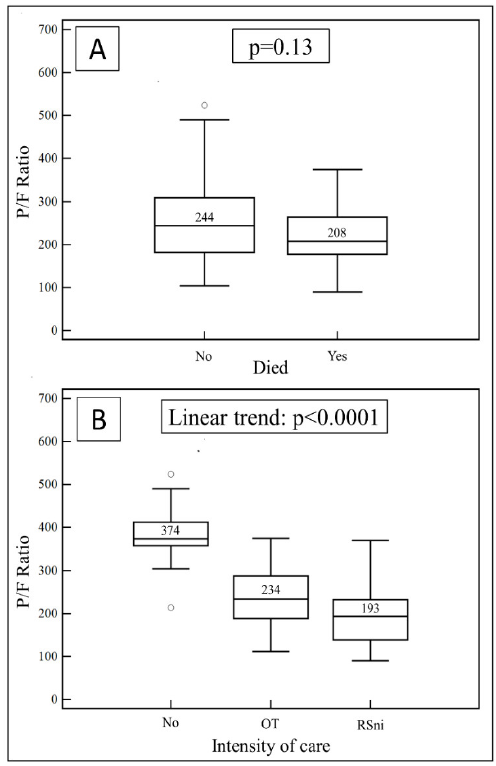
Figure 2. ( A ) PaO 2 /FiO 2 ratio values on admission in COVID-19 patients sorted on whether they died or not during hospitalization. ( B ) PaO 2 /FiO 2 ratio value on admission based on increasing intensity of care during hospitalization.